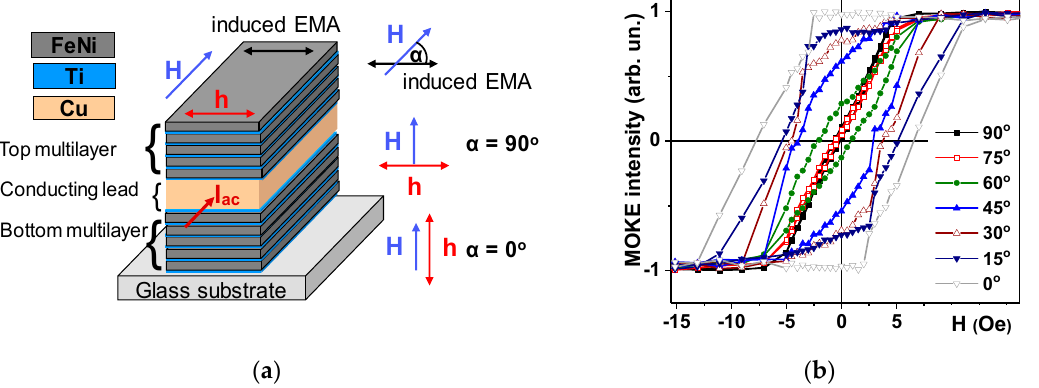
Figure 1. Schematic description of [Ti/FeNi] 6 /Ti/Cu/Ti/[FeNi/Ti] 6 multilayered magnetoimpedance elements: H is an external applied magnetic field, h is a high frequency field created by the alternating flowing current of I ac intensity, easy magnetization axes (EMA) induced during multilayer deposition and α is an angle between the in-plane applied field H and EMA ( a ). Magneto-optical Kerr effect (MOKE) hysteresis loops measured in the center of Ti/FeNi] 6 /Ti/Cu/Ti/[FeNi/Ti] 6 multilayered giant magnetoimpedance effect (GMI) element for different angles between the in-plane applied field H and EMA ( b ).